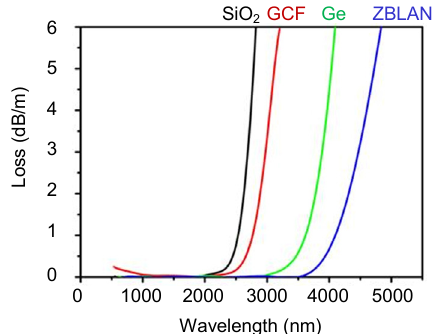
Fig. 2 | Transmission spectra of selected optical fibers (based on the data presented in the available literature) . GCF: germania- core fiber; Ge: germania fiber; ZBLAN: ZrF 4 -BaF 2 -LaF 3 -AlF 3